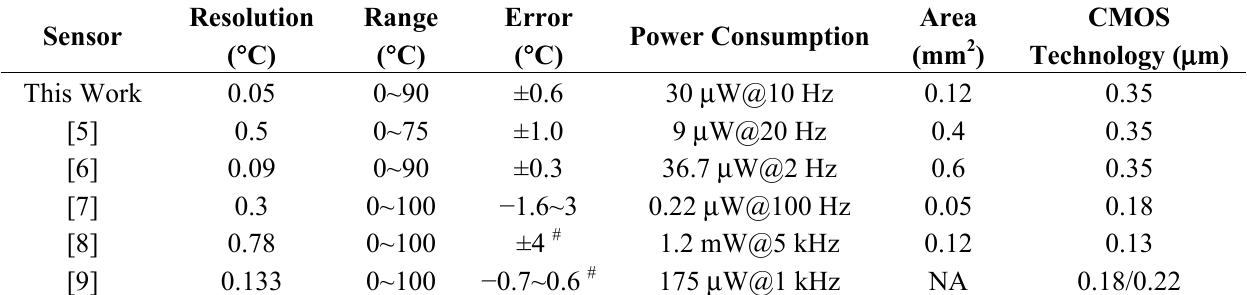
Table 1. Measured performances among time-domain works for easy